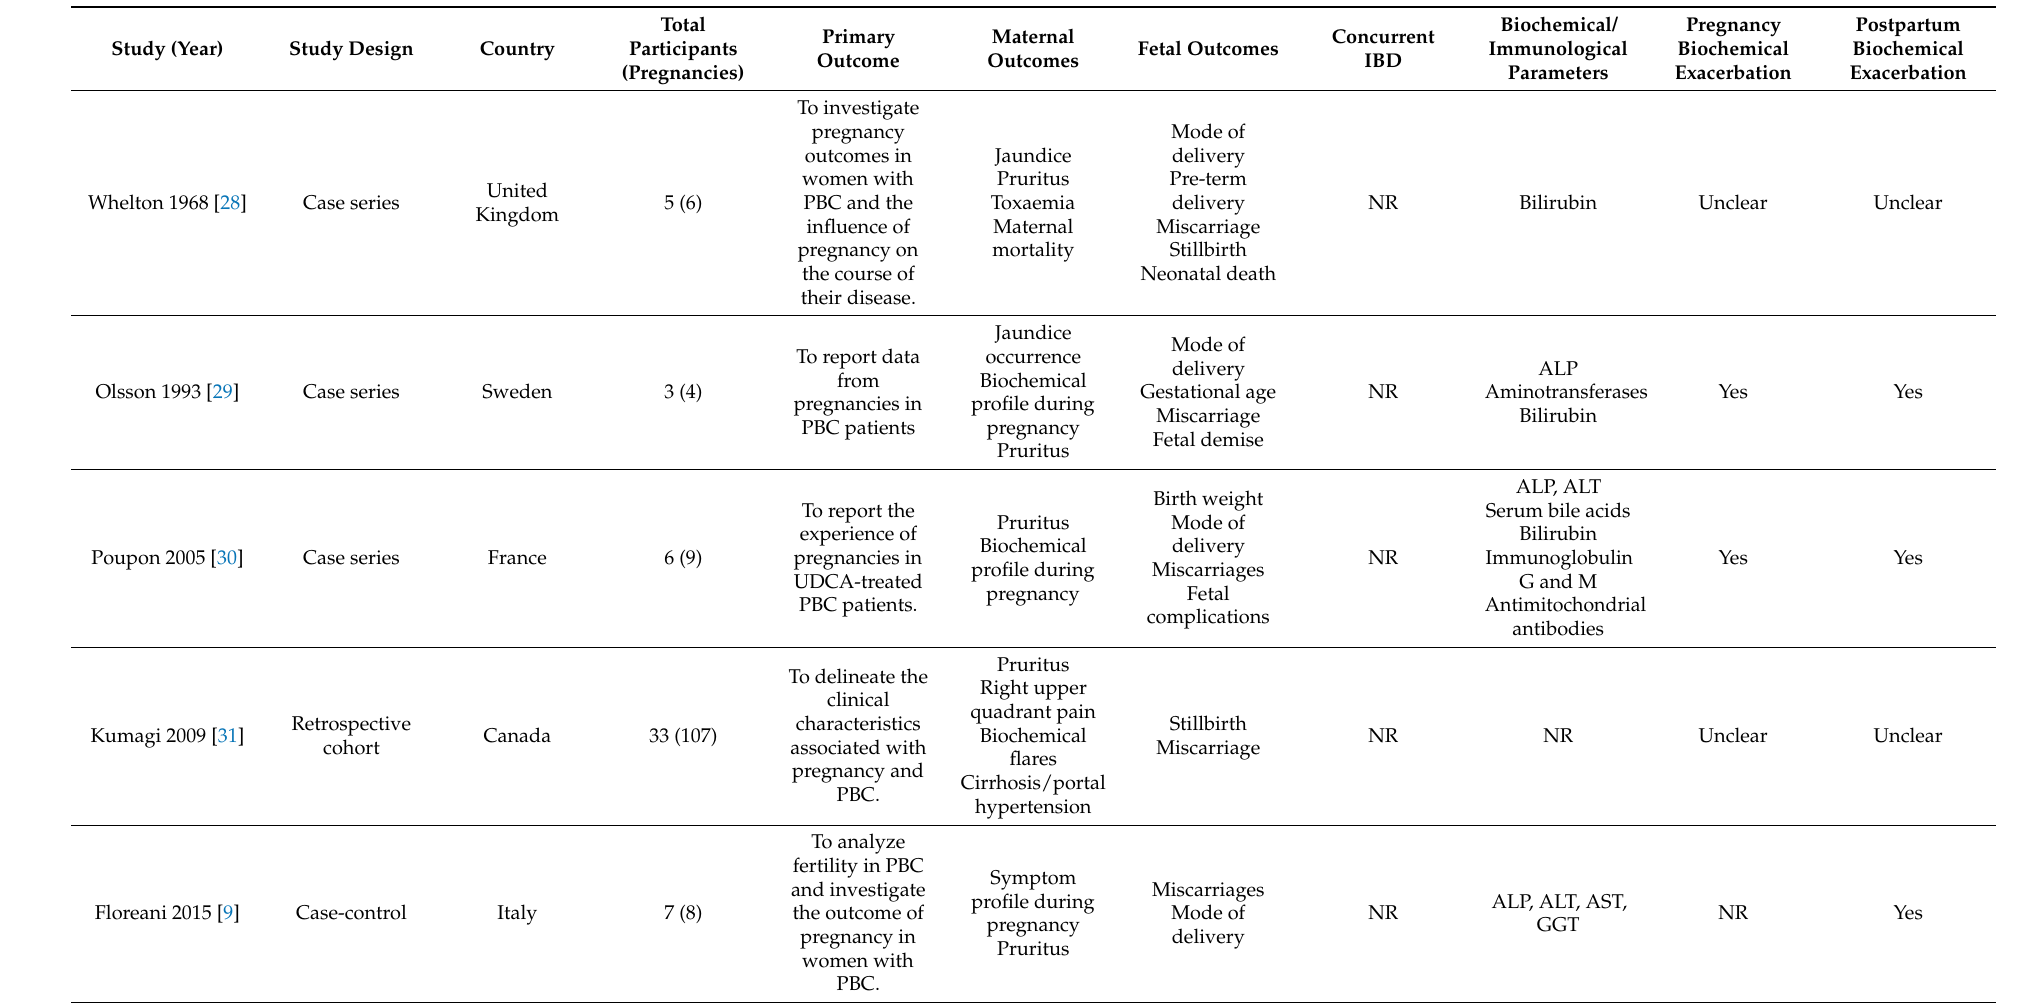
Table 1. Individual study characteristics for primary biliary cholangitis